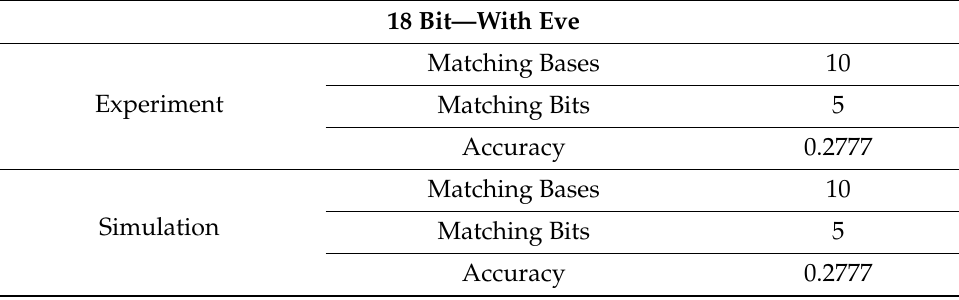
Table 6. An 18 bit accuracy for experiment and simulation—with Eve.